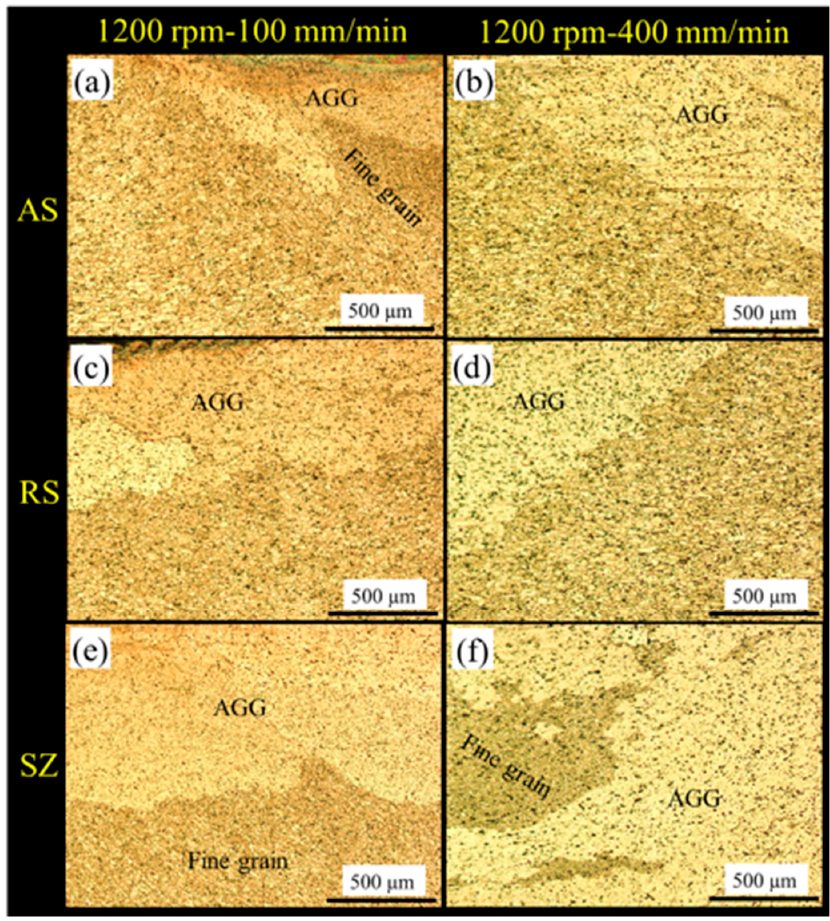
Figure 7. Abnormal grain growth (AGG) in the microstructure of welding zone in PWHT Al6061(T6) samples.